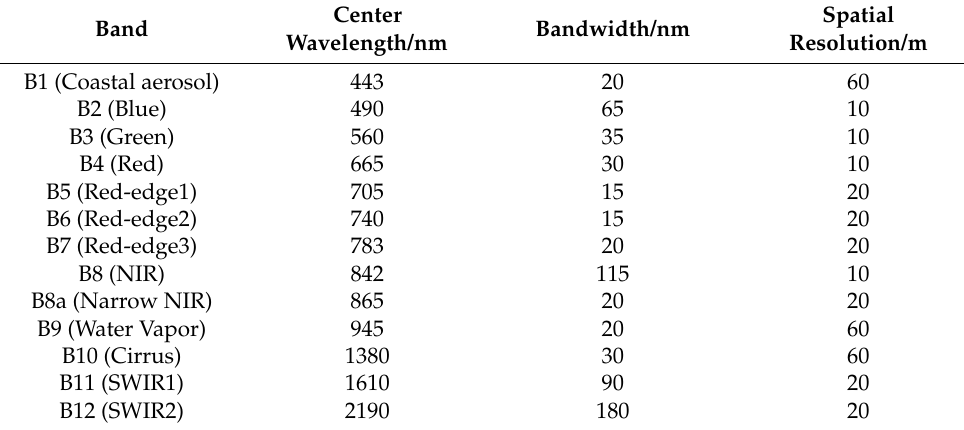
Table 3. Band information of the Sentinel-2